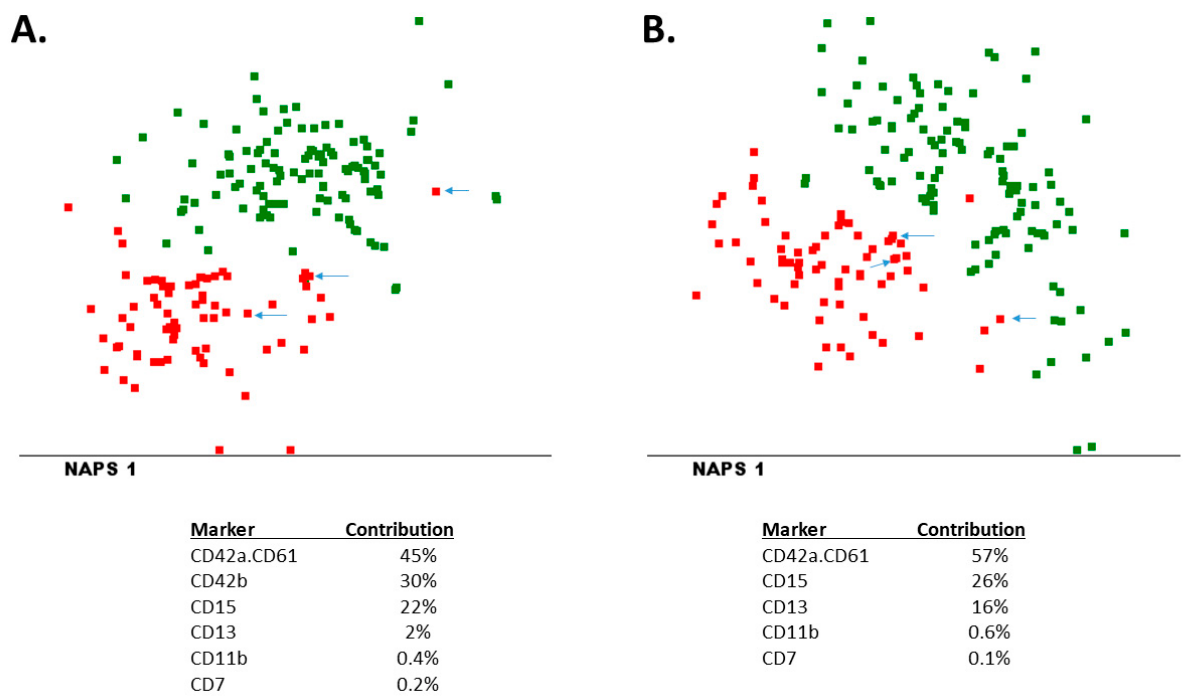
Figure 1. Multivariate analysis of non-AMKL (green dots) and AMKL patients (red dots) using the MFI values of all markers present in EuroFlow AML tubes 1–7 ( A ) or tubes 1–6 ( B ). Pattern classification was performed using NAPS, and the markers contributing to the pattern classification are shown in the bottom part of the figure. The three AMKL patients not expressing CD42a.CD61, CD41 or CD42b (MFI < 1000) are indicated by arrows.